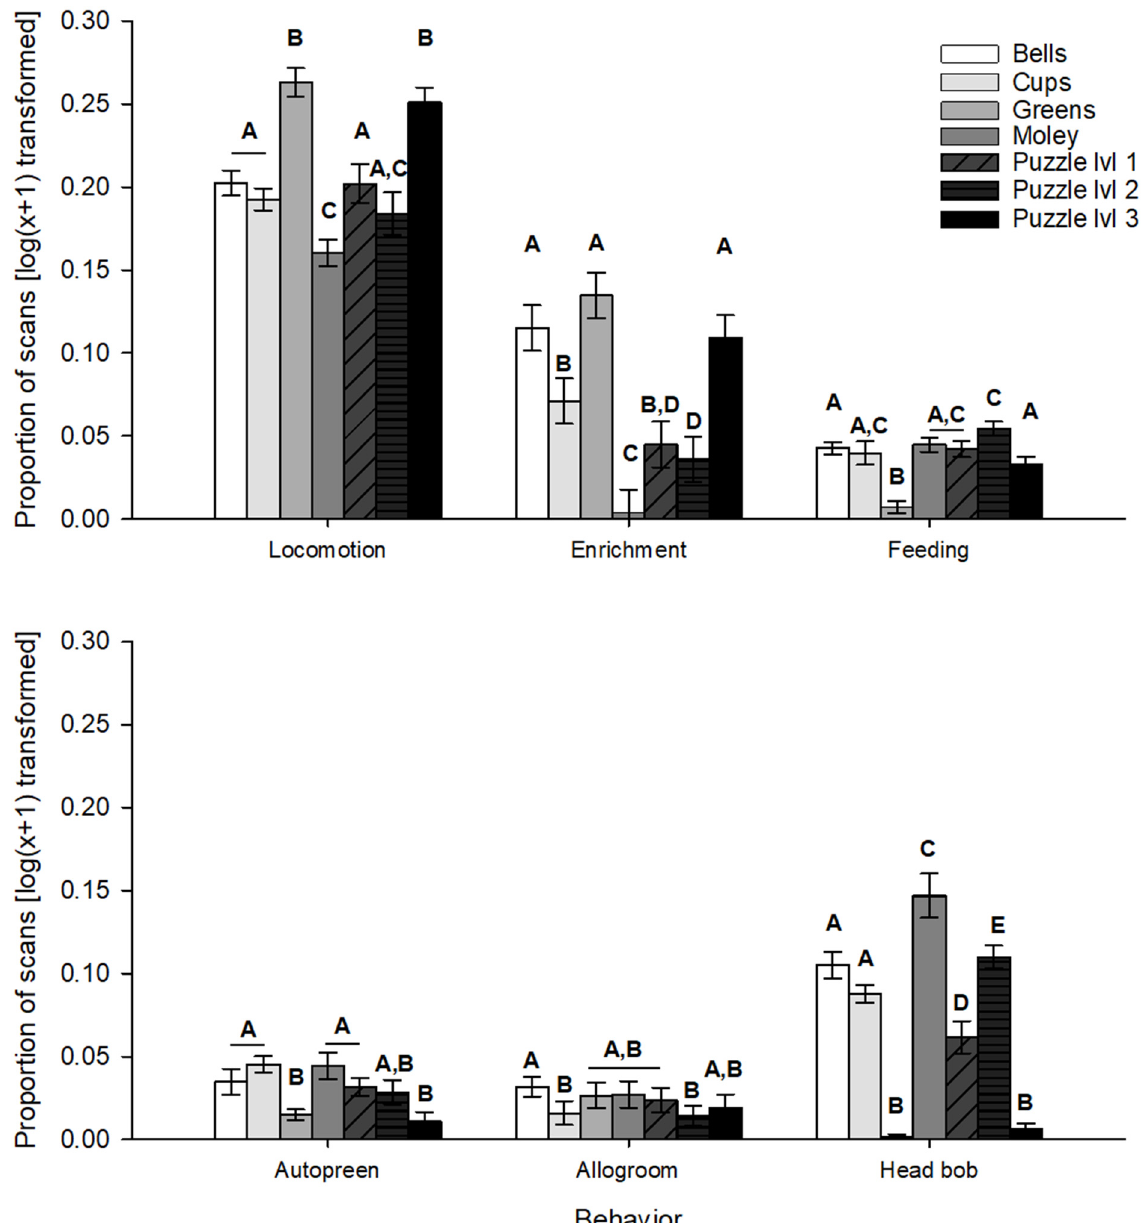
Figure 4. Differences in behaviors based on enrichment item in post-enrichment addition periods. Letters indicate groupings of categories with significantly different responses for the listed behavior.